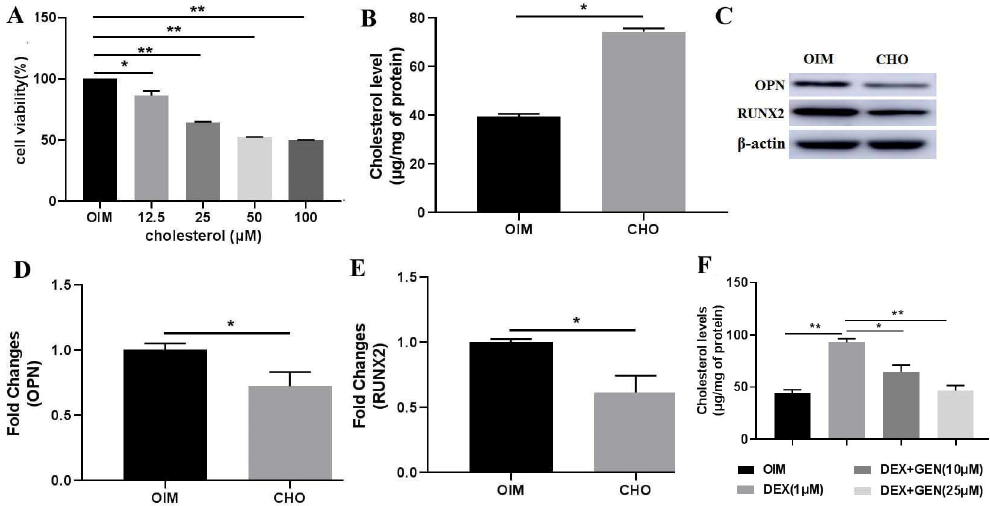
Figure 3. GEN ameliorated DEX-induced cholesterol accumulation in MC3T3-E1 cells. ( A ) MTT assays were conducted to investigate the effects of cholesterol on cell viability. ( B ) The level of intracellular cholesterol after administration with exogenous cholesterol. ( C – E ) The protein expression of RUNX2 and OPN in CHO (50 µ M)-treated MC3T3-E1 cells was determined by western blot. ( F ) The level of the total intracellular cholesterol was measured by the ELISA kit. All experiments were implemented separately in triplicate. * p < 0.05; ** p < 0.01. OIM, osteogenic induction medium; CHO,